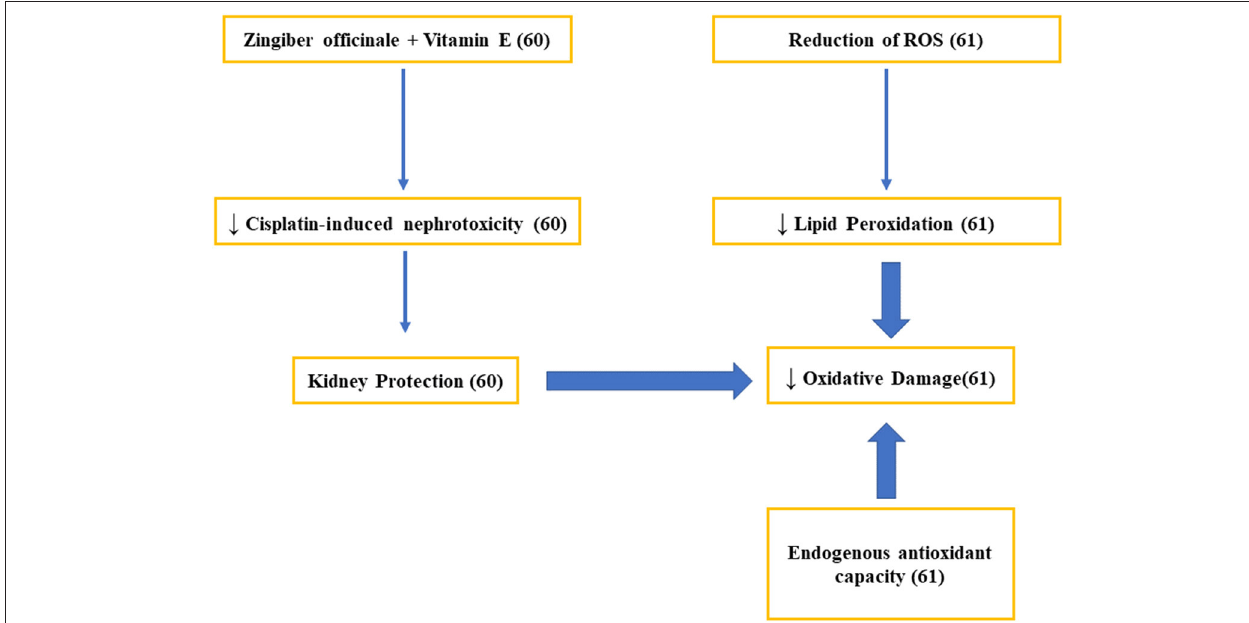
FIGURE 3 | Studies on the mechanisms related to the antioxidant activity of ginger.